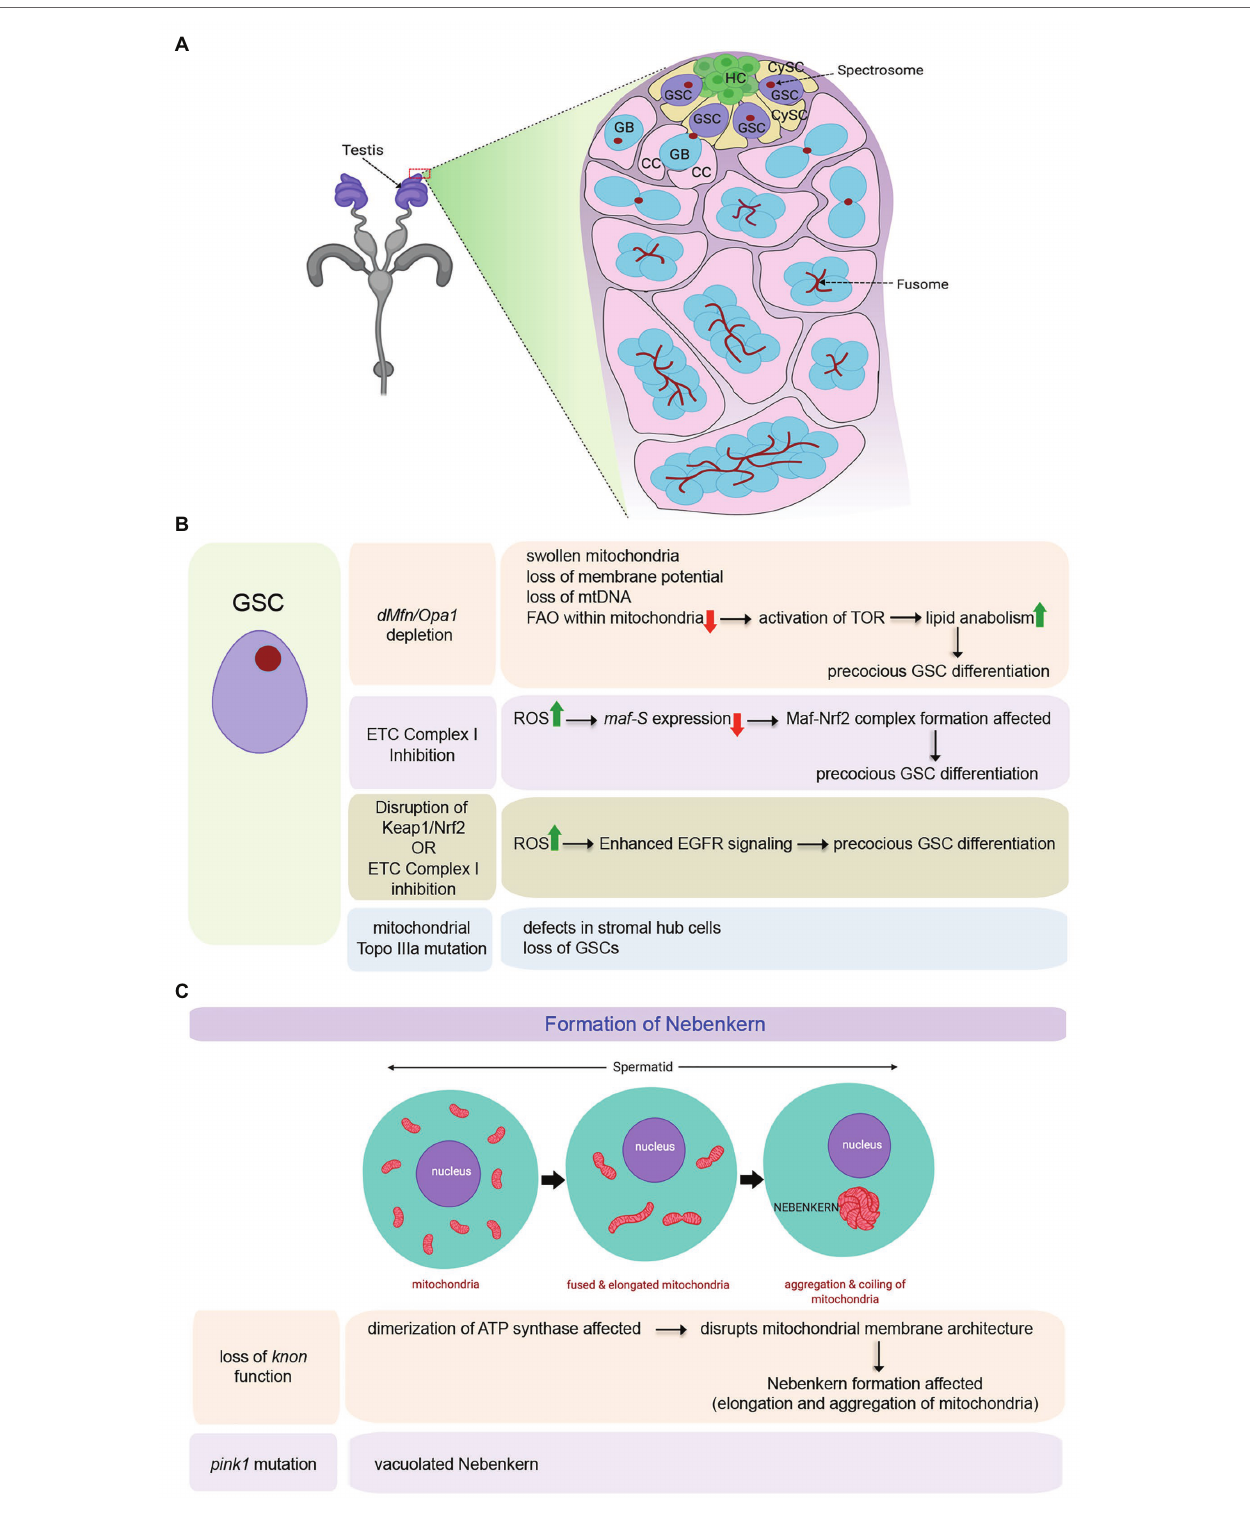
FIGURE 1 | Role of mitochondria in maintenance and differentiation of male Germline Stem Cells (GSCs) in Drosophila . (A) Schematic representation of the tip of the adult testis showing the anatomical position of male GSCs and other associated cell types. The expanded forms of the acronyms used are provided in the text. (B) Table showing the diverse outcomes of manipulating mitochondrial structure and function in the male GSCs. (C) Schematic representation for mitochondrial fusion and aggregation to form the Nebenkern in the spermatids. Loss of knon and pink1 function affects Nebenkern